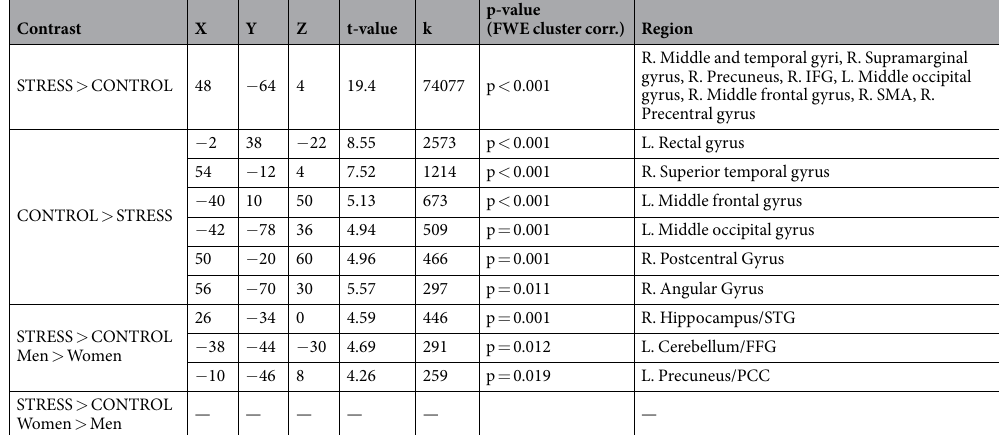
— — — — Table 2. Significant clusters in neural activation for specific contrasts. Coordinates are given in MNI space. Only the maximum peak is reported for each cluster. Data is cluster-level FWE-corrected (p < 0.05) and p-values are listed. Note. R = right, L = left, k = cluster size in